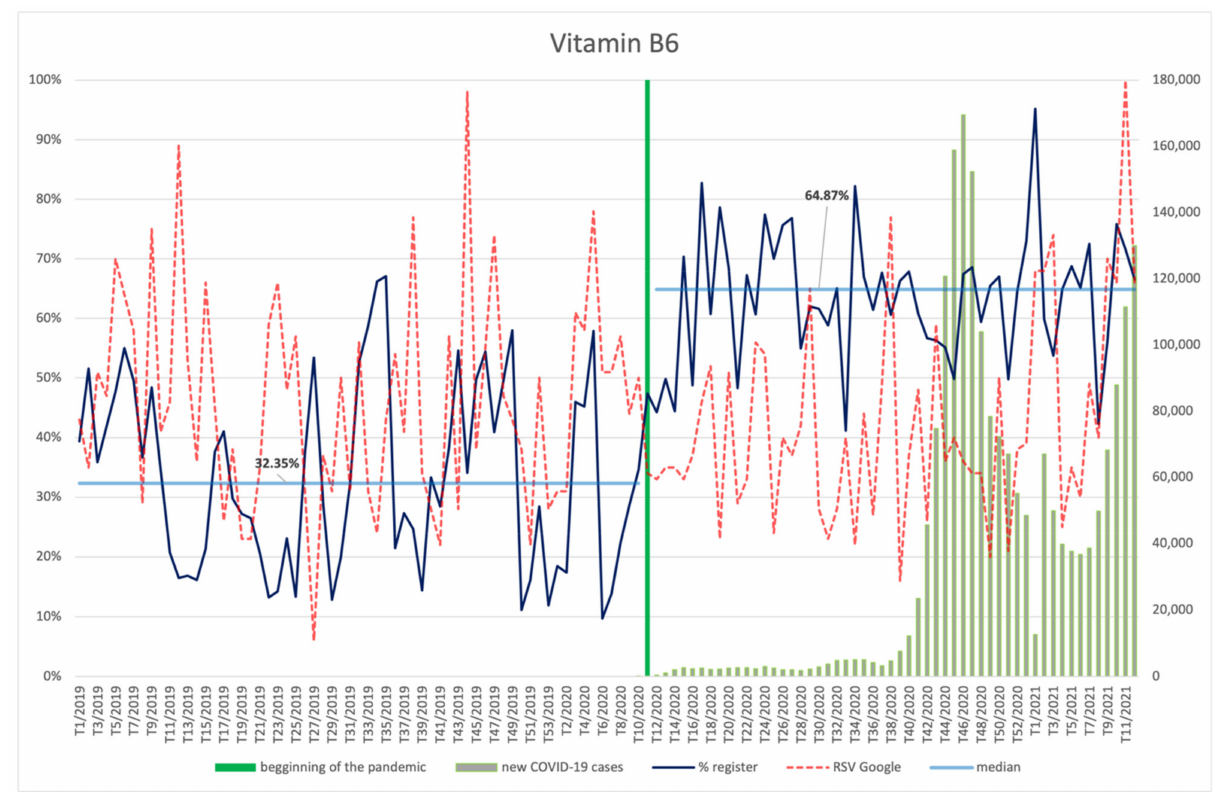
Figure 13. Comparison between the number of new registrations of products containing vitamin B6, the number of COVID-19 cases, and the frequency of search for information on the ingredient in the Google